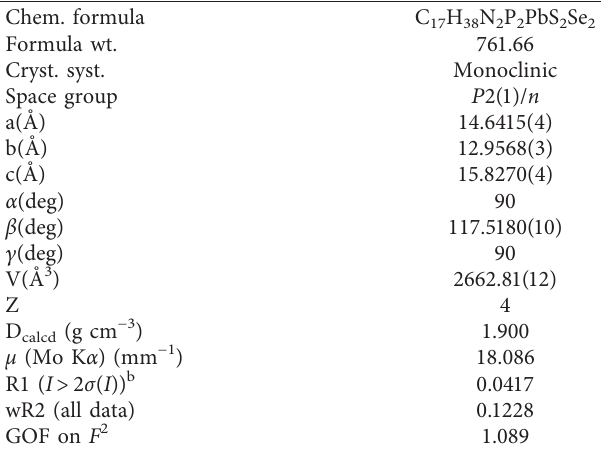
17 H 38 N 2 P 2 PbS 2 Se 2 .